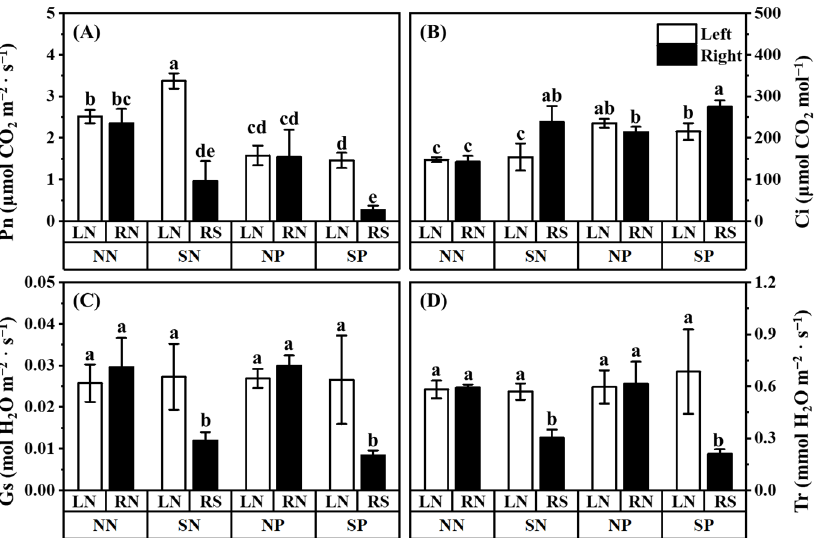
Figure 4. Effects of Pb and shading on the net photosynthetic rate Pn ( A ), intercellular CO 2 concentration Ci ( B ), stomatal conductance Gs ( C ), and transpiration rate Tr ( D ) in the leaves of M. alba . F and p -value of ANOVA are listed in Supplementary Table S3. Different letters above the columns in each graph indicate a significant difference among the means by Tukey’s test ( p < 0.05 ). The abbreviation is consistent with Figure 1.